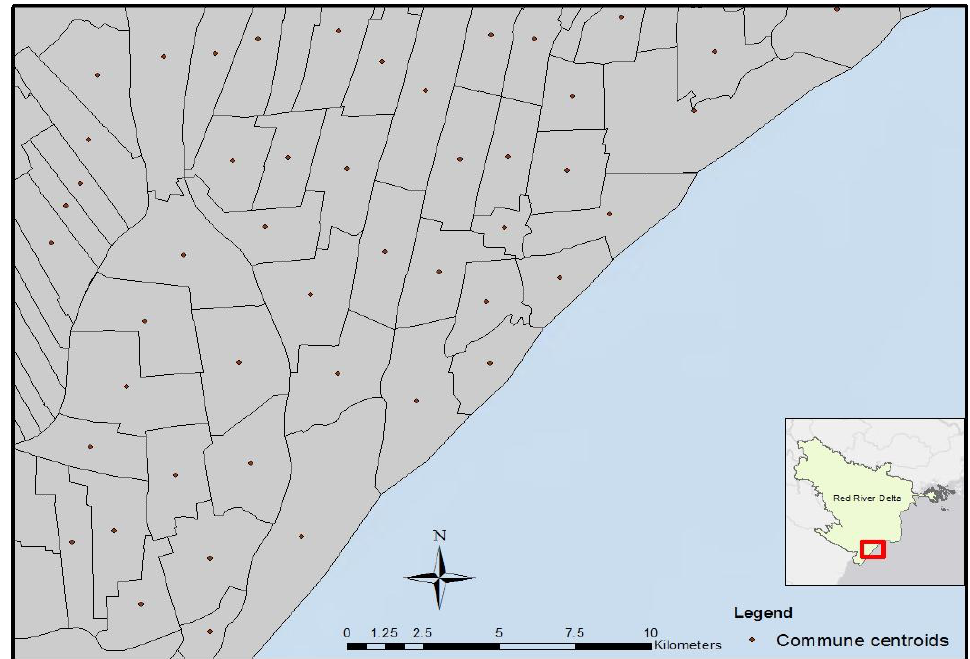
Figure 3. Commune administrative polygon and commune